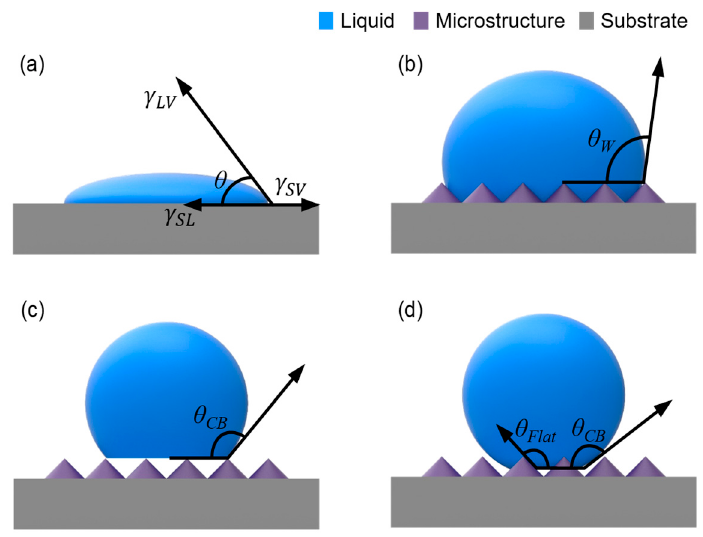
Figure 1. Wetting behavior of a liquid droplet on rough surface: ( a ) Young’s model; ( b ) Wenzel’s model; ( c ) Cassie’s model; and ( d ) combined Cassie-Wenzel model.